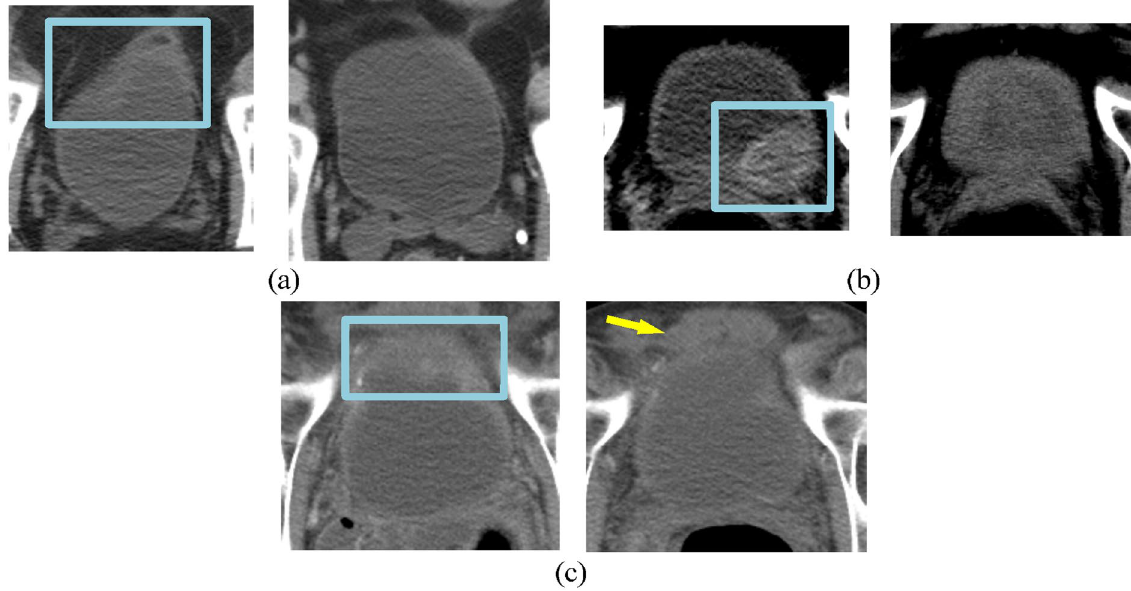
Figure 7. Examples of pre- (on the left side of each image pair) and post- (on the right side of each image pair) treatment bladders that responded fully to treatment, and the differences in the predictions by the computer models and radiologists. ( a ) All three computer methods and the radiologists correctly predicted the outcome of treatment for this case. ( b ) The three computer methods correctly identified the case as becoming T0 tumor, while the radiologists did not. There was residual bladder wall thickening, presumably related to the treatment, causing the radiologists to falsely conclude that there was persistent tumor. ( c ) The radiologist correctly identified that there was no residual tumor on post-treatment images, while the three computer methods failed to classify this case correctly. This was likely due to misidentification of perivesical tissue (arrow) as residual tumor by the computer models. The box on the pre-treatment scan represents the location of the lesion as marked by one of the